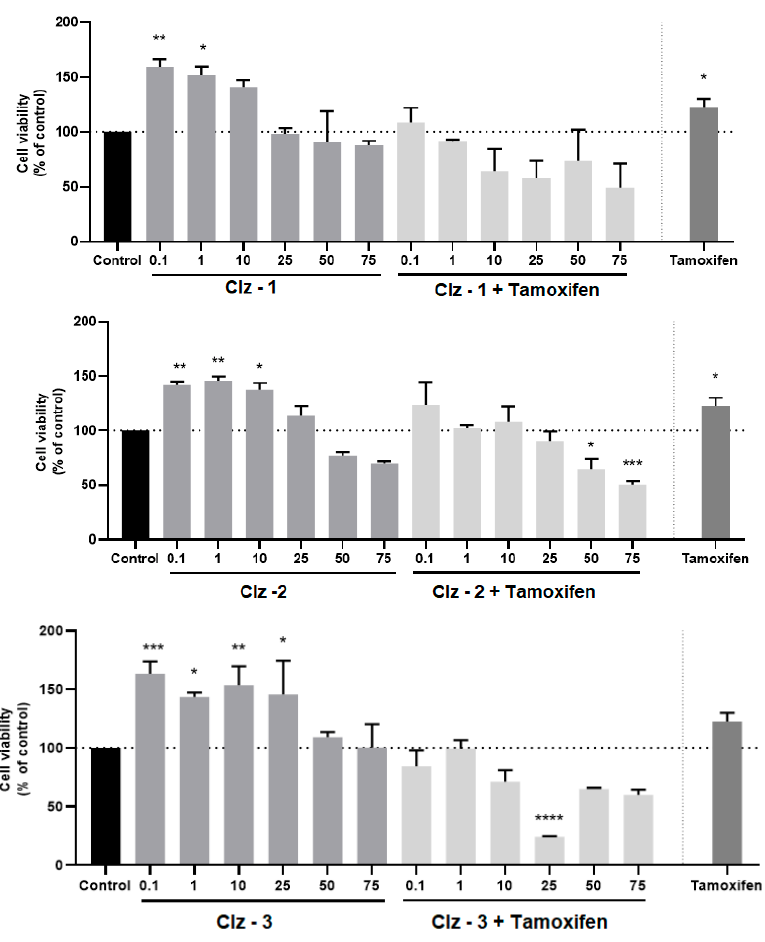
Figure 3. Relative viabilities of MCF-7 cells after 24-h incubations of various concentrations of either just Clz–1, Clz–2, and Clz–3, or each Coelenterazine derivative combined with Tamoxifen (2.21 µ M). * Significantly different from control (p <0.05).